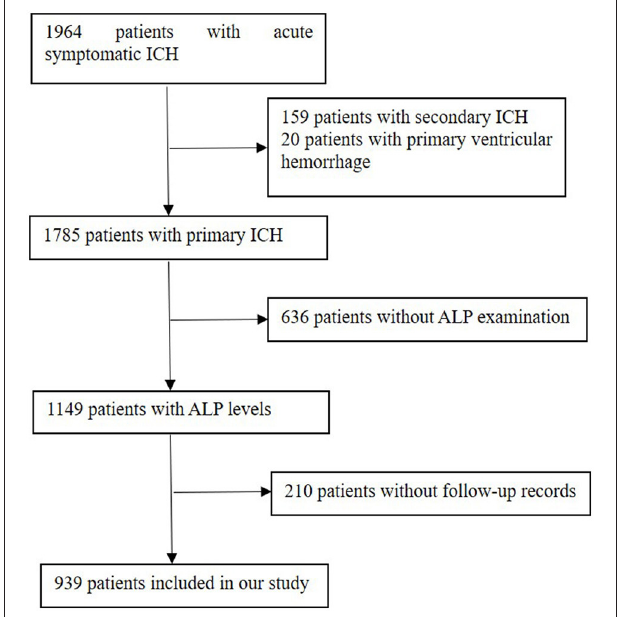
FIGURE 1 | Flow diagram of study patients. ICH, intracerebral hemorrhage; ALP, alkaline phosphatase.